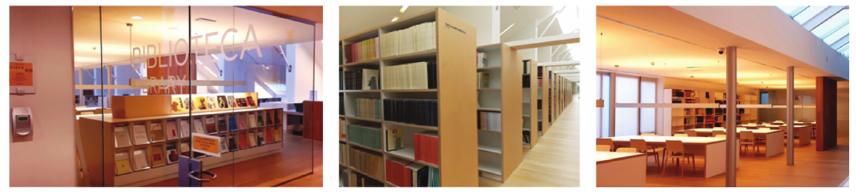
Fig. 3: Rooms of the Library in the National Archaeological Museum